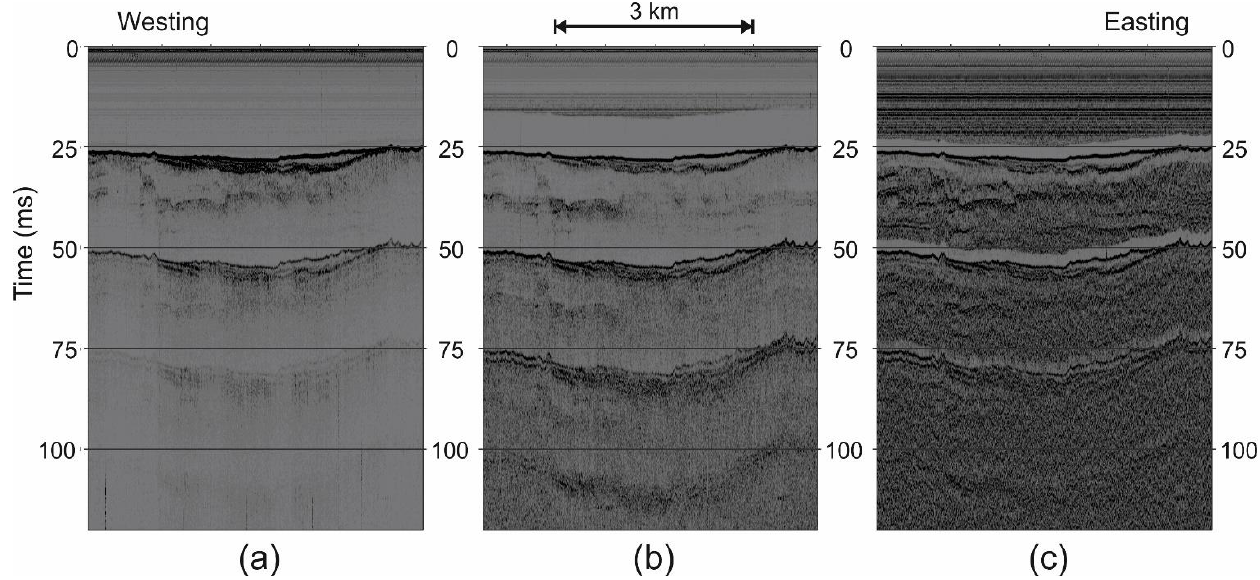
Figure 3. Chirp data without gain recovery ( a ) and with an automatic gain control using a window length of 10 ms ( b ) and 3 ms ( c ).